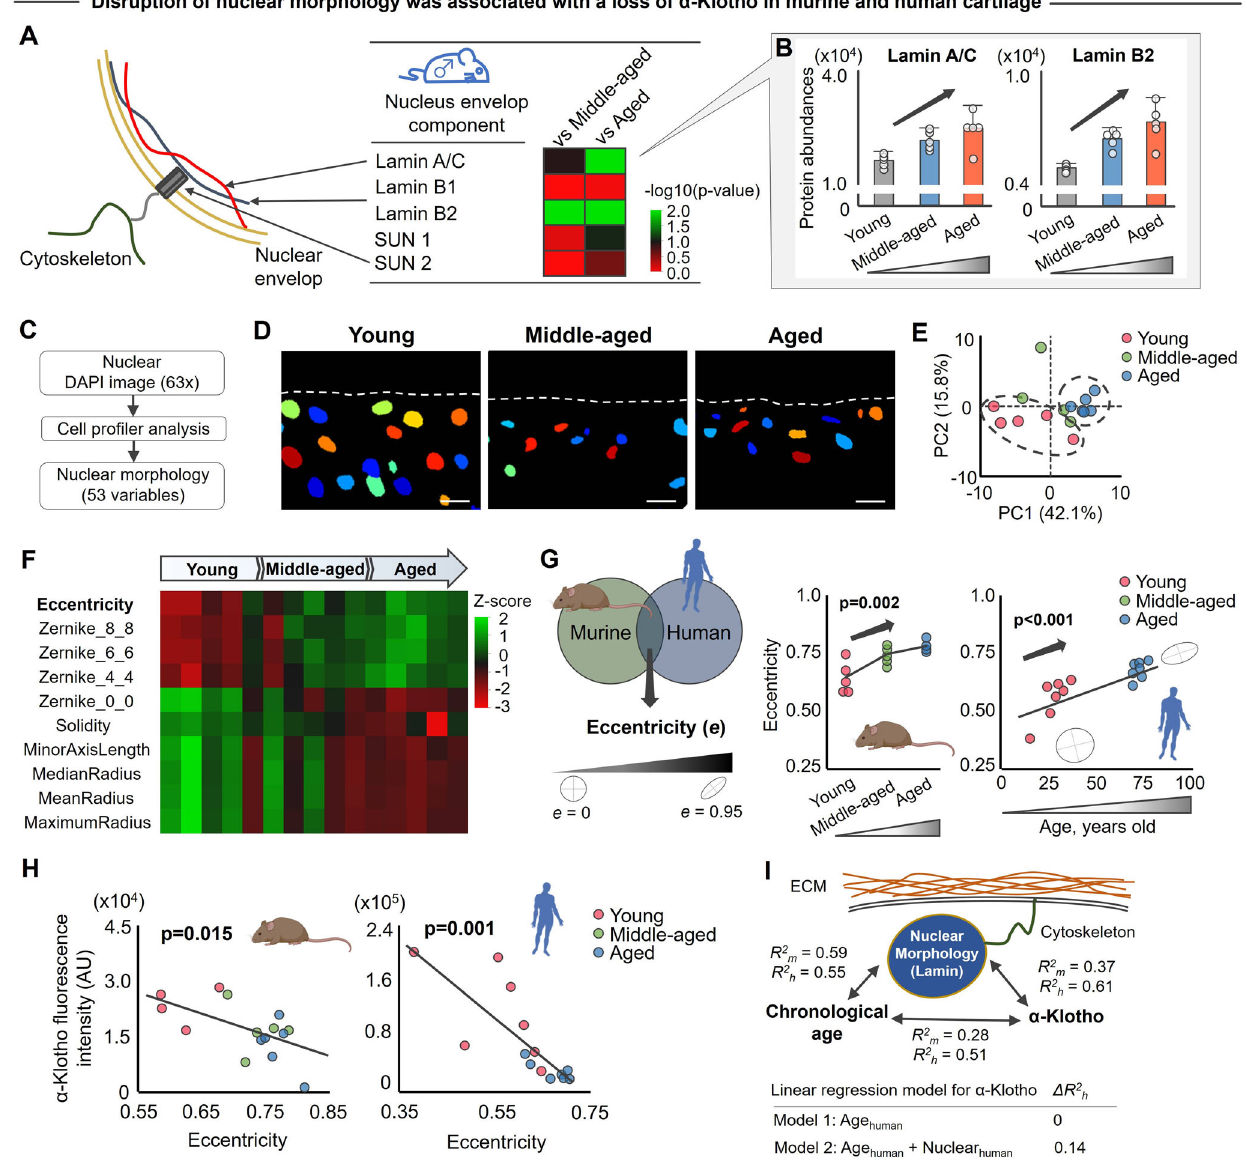
Fig. 3 | Age-related α -Klotho decline is accompanied with nuclear morpholo- gicalalterations.A Age-relatedchangesinnuclearenvelopeproteinsinmalemice quanti fi ed by mass spectrometry-based proteomics. The heat map represents log10( p value)of eachprotein,with>1.3consideredsigni fi cant. B Agingincreased lamin A/C and lamin B2 protein expression ( n =5/age). C Analytical fl ow of the nuclear morphological analysis (53 variables) using CellPro fi ler software.